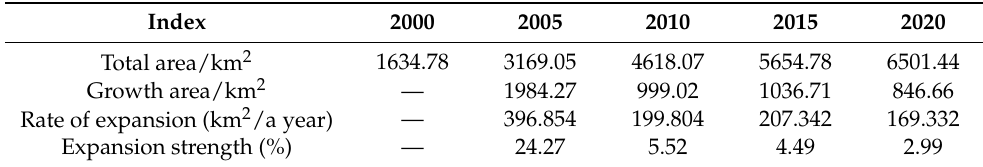
Table 2. Statistics of urban agglomeration in Guangdong Province.